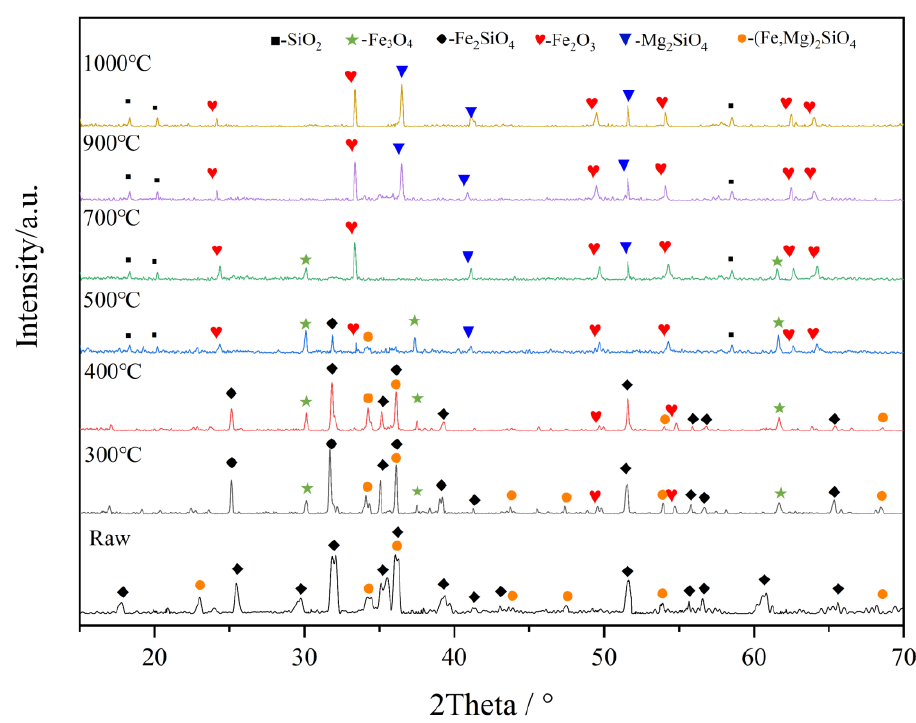
Figure 6. XRD patterns of nickel slag samples after oxidation for 30 min at different temperatures. Minerals 2020 , 10 , x FOR PEER REVIEW